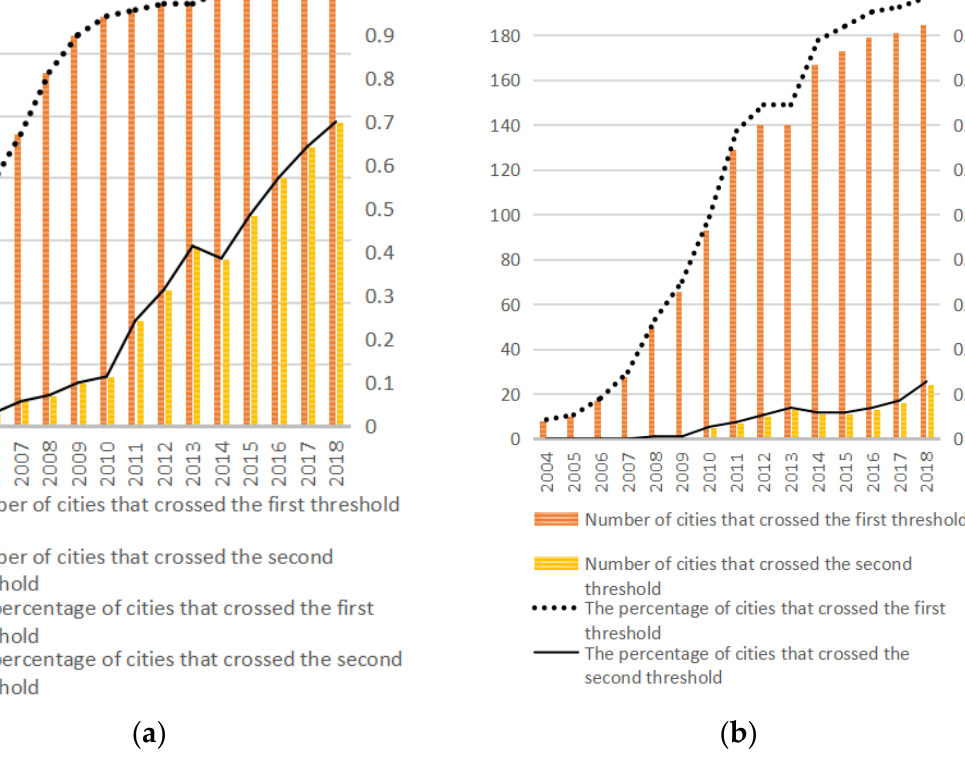
Figure 7. Comparison of threshold crossing between innovative and non-innovative cities (taking economic growth as threshold): ( a ) Innovative city, ( b ) Non-innovative city.